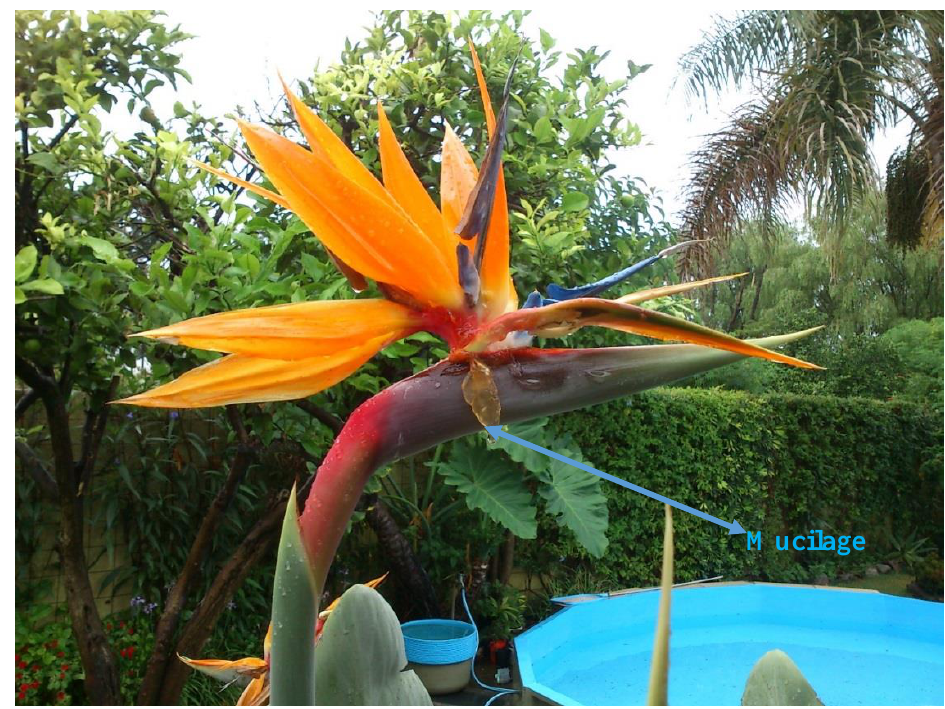
Figure 1. Strelitzia reginae flower and mucilage.